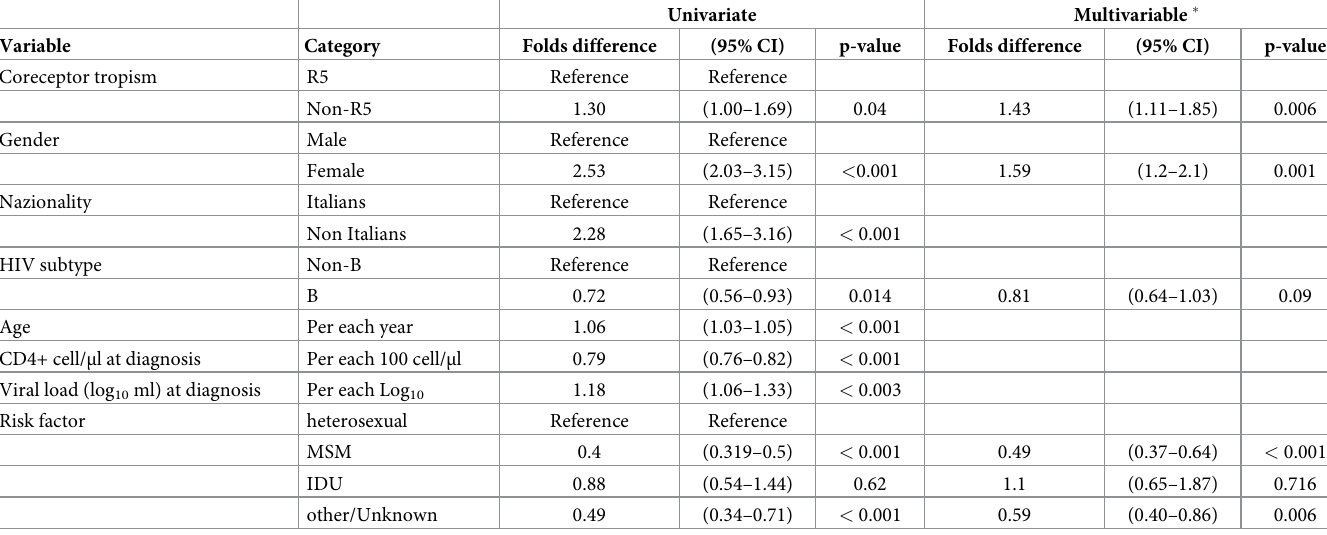
Table 3. Association between patients’ and viral characteristics and VACS index percentage risk.